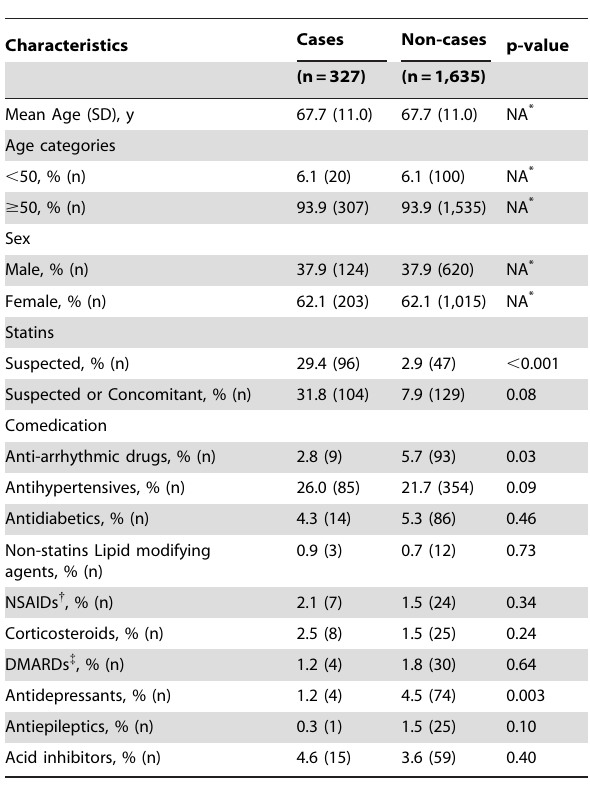
Table 1. Baseline characteristics of the Polymyalgia Rheumatica study population.